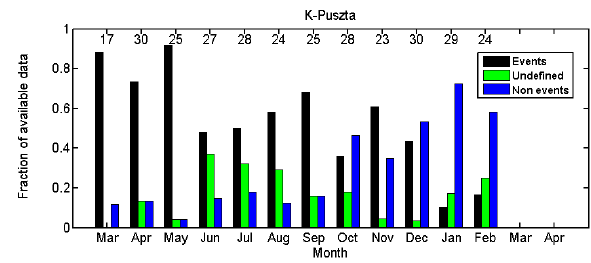
Fig. A6. The fraction of event, undefined and non-event days out of all analyzed days during each month in the year at Melpitz, Germary, during May 2008–April 2009.